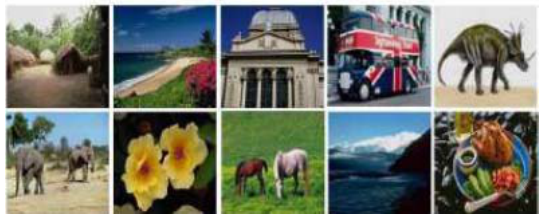
Fig. 10. Sample images of each category of Corel dataset .